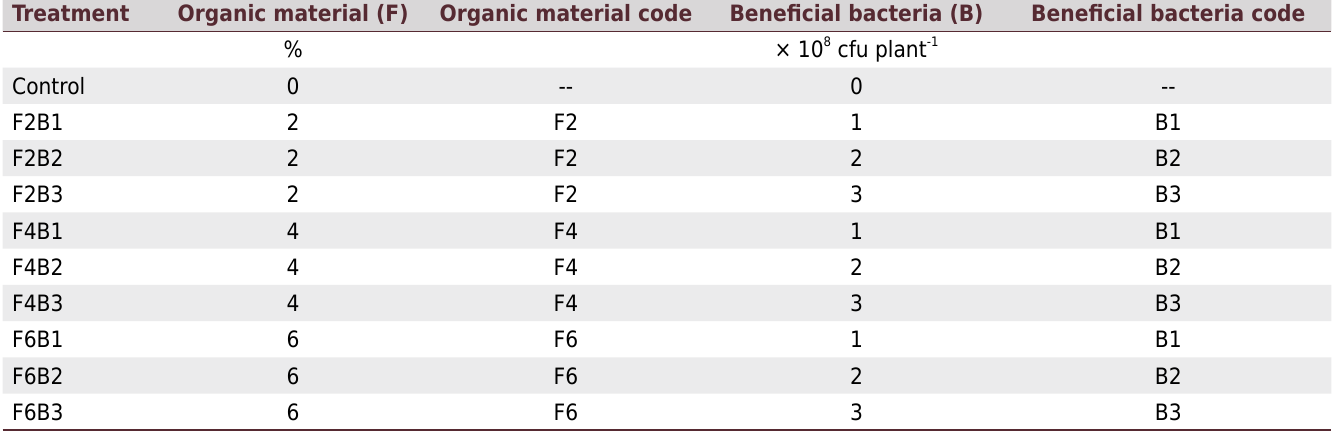
Table 1. Different organic materials and beneficial bacteria treatments Treatment Organic material